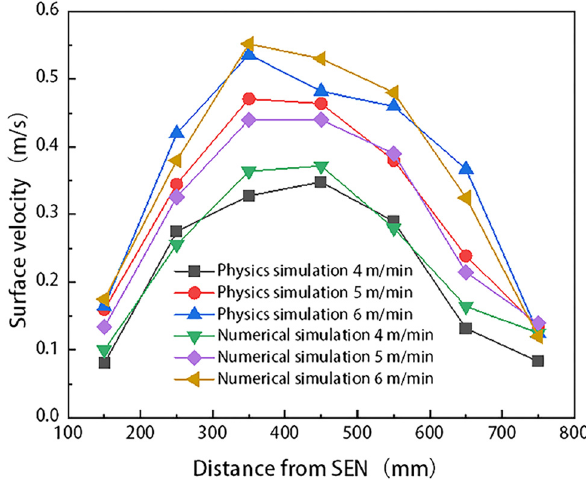
Figure 5: In fl uence of casting speed on funnel mold surface velocity.